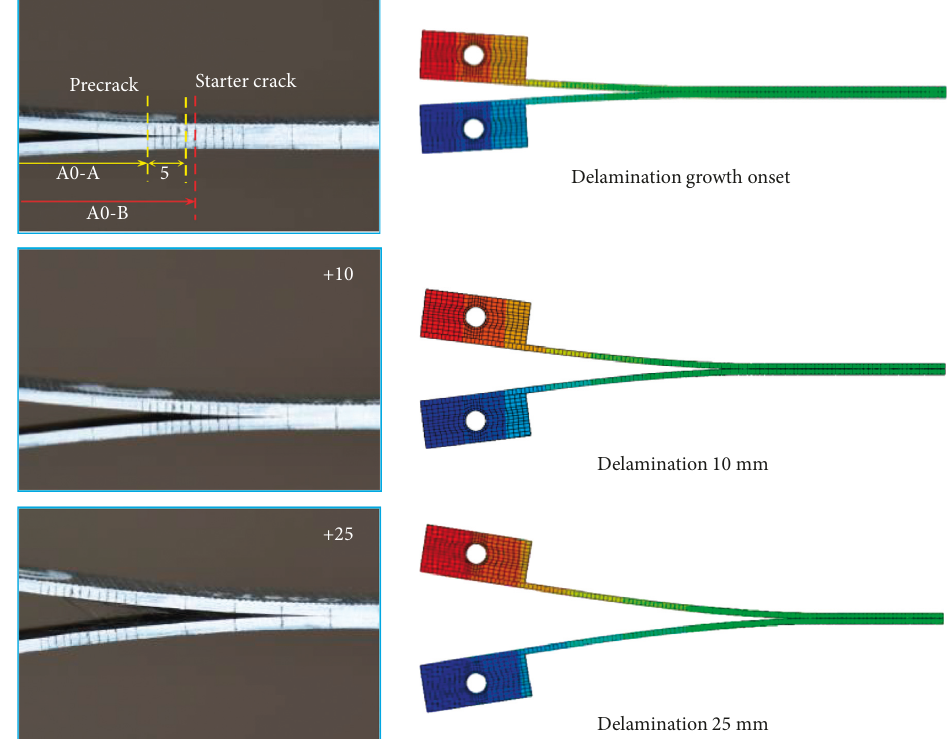
Figure 19: DCB: experimental and numerical deformed shape.